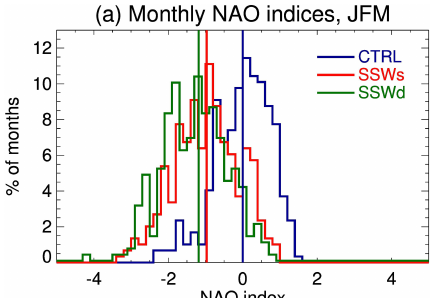
Figure 1. Monthly mean NAO indices from a set of nudged integra- tions similar to those described in this protocol. The zonally sym- metric component of the stratosphere in the control (CTRL) run is nudged to the model climatology, while those of SSWs and SSWd are nudged, respectively, to the evolution of a vortex split and a vor- tex displacement event simulated by a free-running configuration of the same model. (Figure 12a from Hitchcock and Simpson, 2014, © American Meteorological Society. Used with